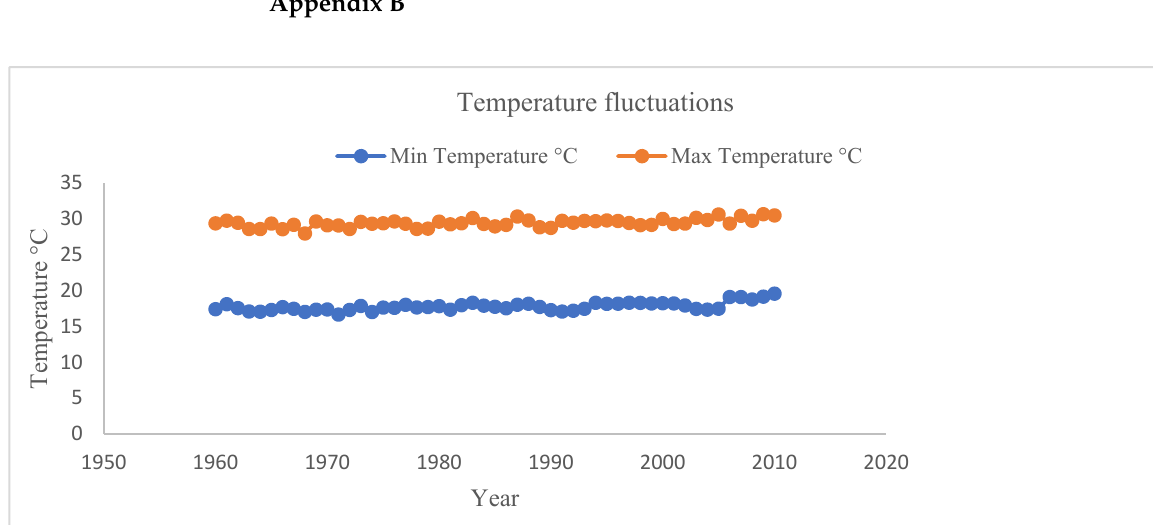
Figure A2. Temperature fluctuations—Changes in annual temperature (°C) measured at Moshi Airport Moshi Municipal, Kilimanjaro station No: 9337004 coordinates 3°21′0″ S and 37°19′48″ E.